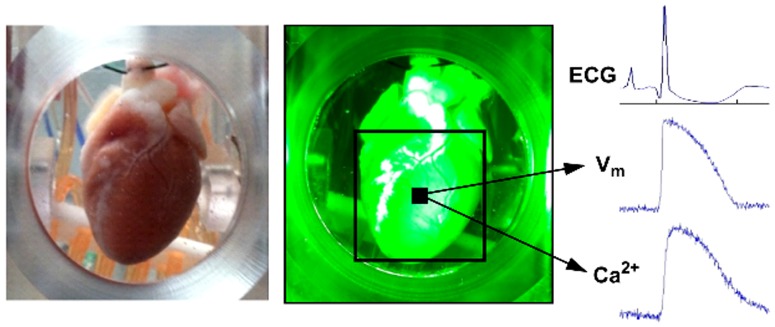
Optical mapping of Vm and Ca2+ in isolated rabbit hearts.
Left, Langendorff-perfused isolated rabbit heart mounted in the tissue bath with the anterior surface of the ventricles centered in the viewing window. Center, heart illuminated with the high power green (530 nm peak λ) LEDs with the black box representing the field of view. Right, representative recordings of the volume-conducted electrocardiogram (ECG), optical AP (Vm), and CaT (Ca2+) measured simultaneously during a single paced beat.